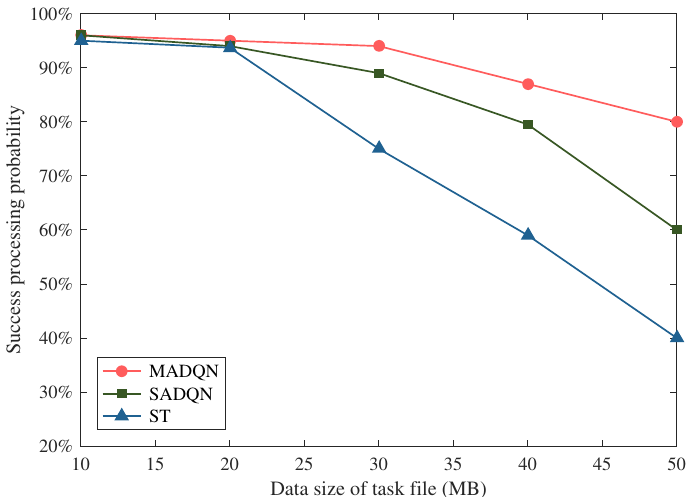
Figure 9. The effect of the data size of the task file on the successful processing